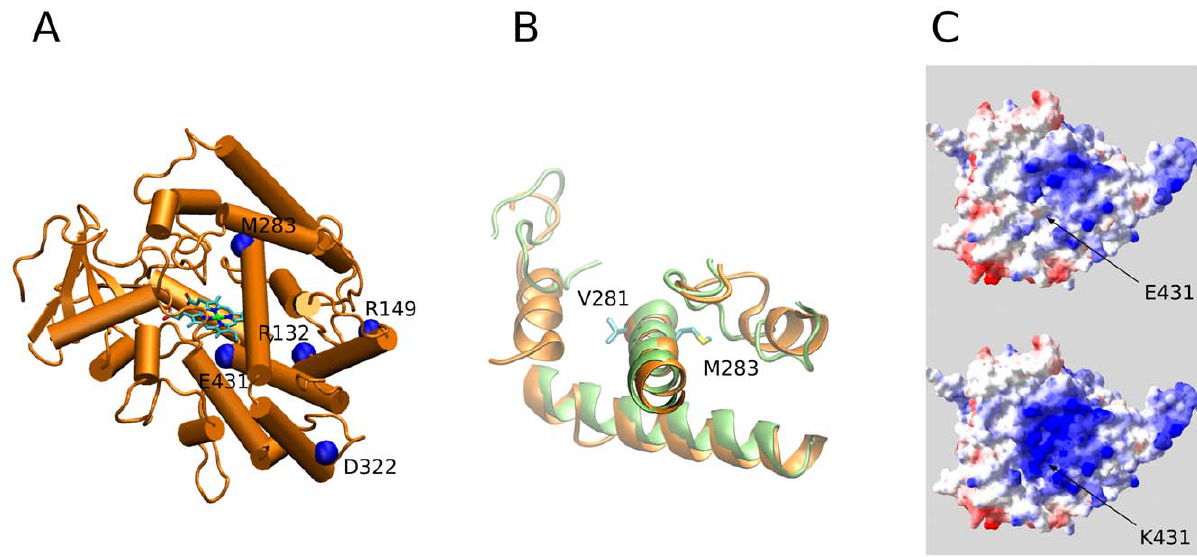
Figure 3: Structural analysis. A : Cartoon representation of the structure of CYP21A2. Residues implicated in the novel mutations found are labeled and highlighted by blue spheres. The residue D322 is also represented. Heme cofactor is depicted in sticks. B : Model discrepancies in the surroundings of V281. Detail of the superimposition of the Biskit (green) and 2GEG (orange) models. V281 and M283 are named and depicted in sticks. C : Enhancement of the basic region in the mutant surface. Surface electrostatics of the wild type E431 and mutant K431 are presented. Acidic regions are depicted in red and basic ones in blue.